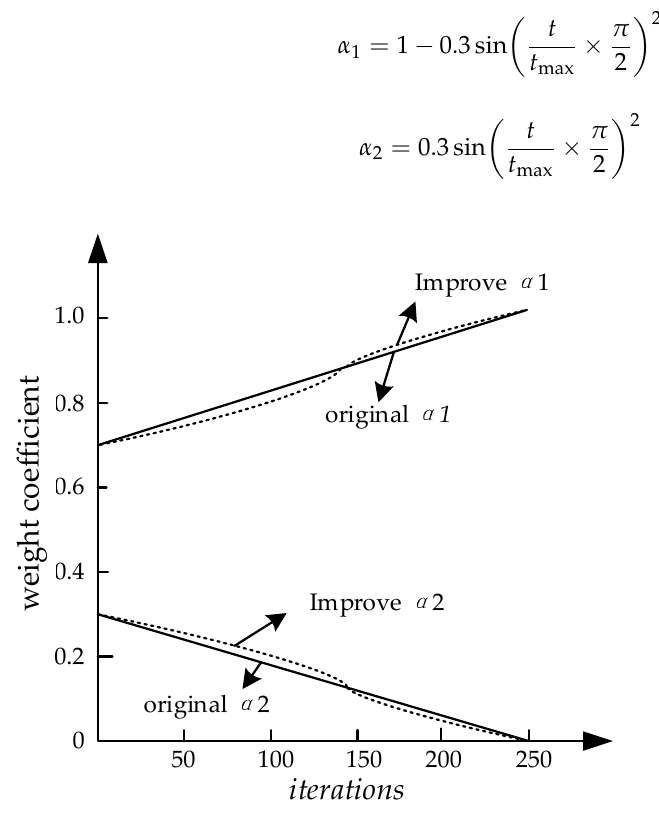
Figure 6. A comparison of weight coefficient improvements.